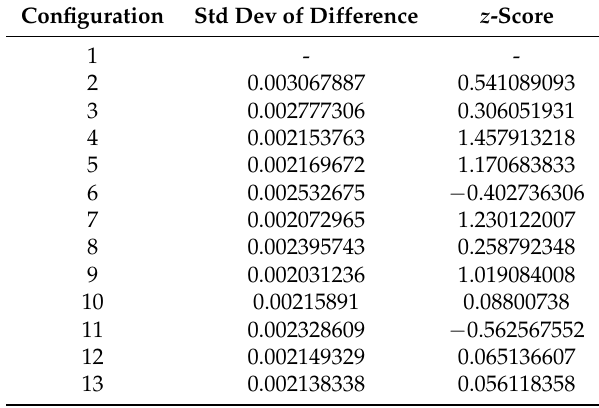
Table 11. Large-sample unpaired tests on the two means of firstHitCost in Table